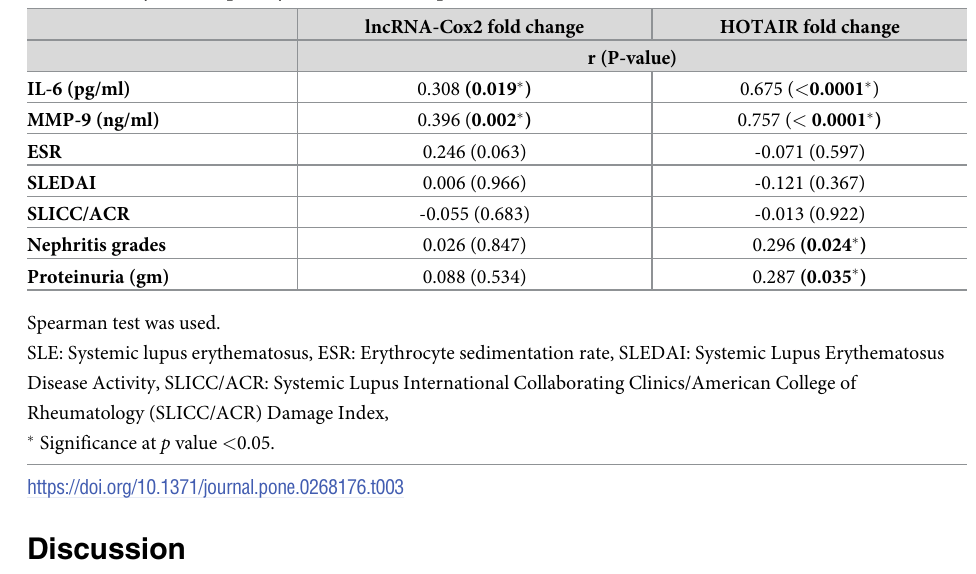
Table 4. Multiple logistic regression analysis of systemic lupus erythematosus (SLE). B